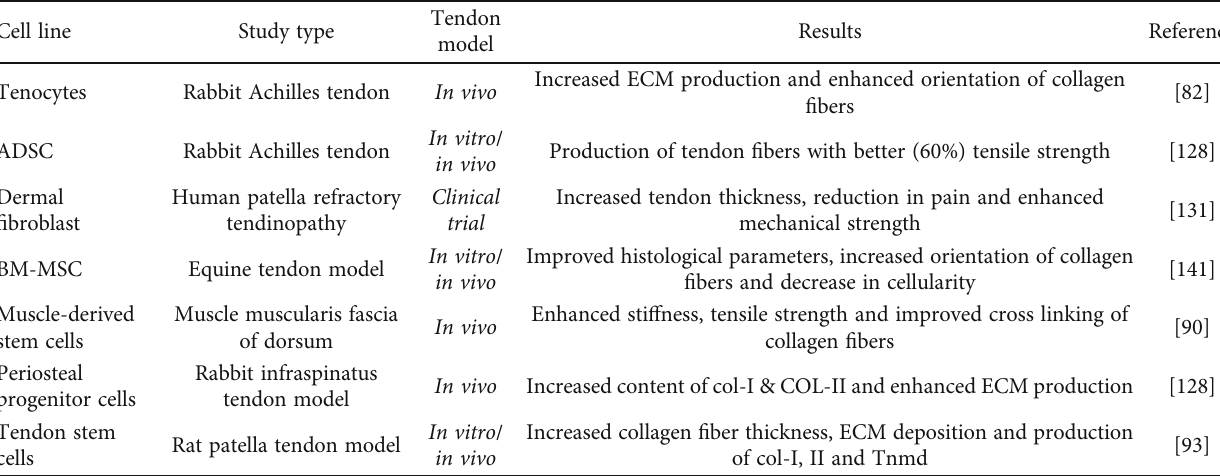
Table 3: Recent cell-based approach for tendon